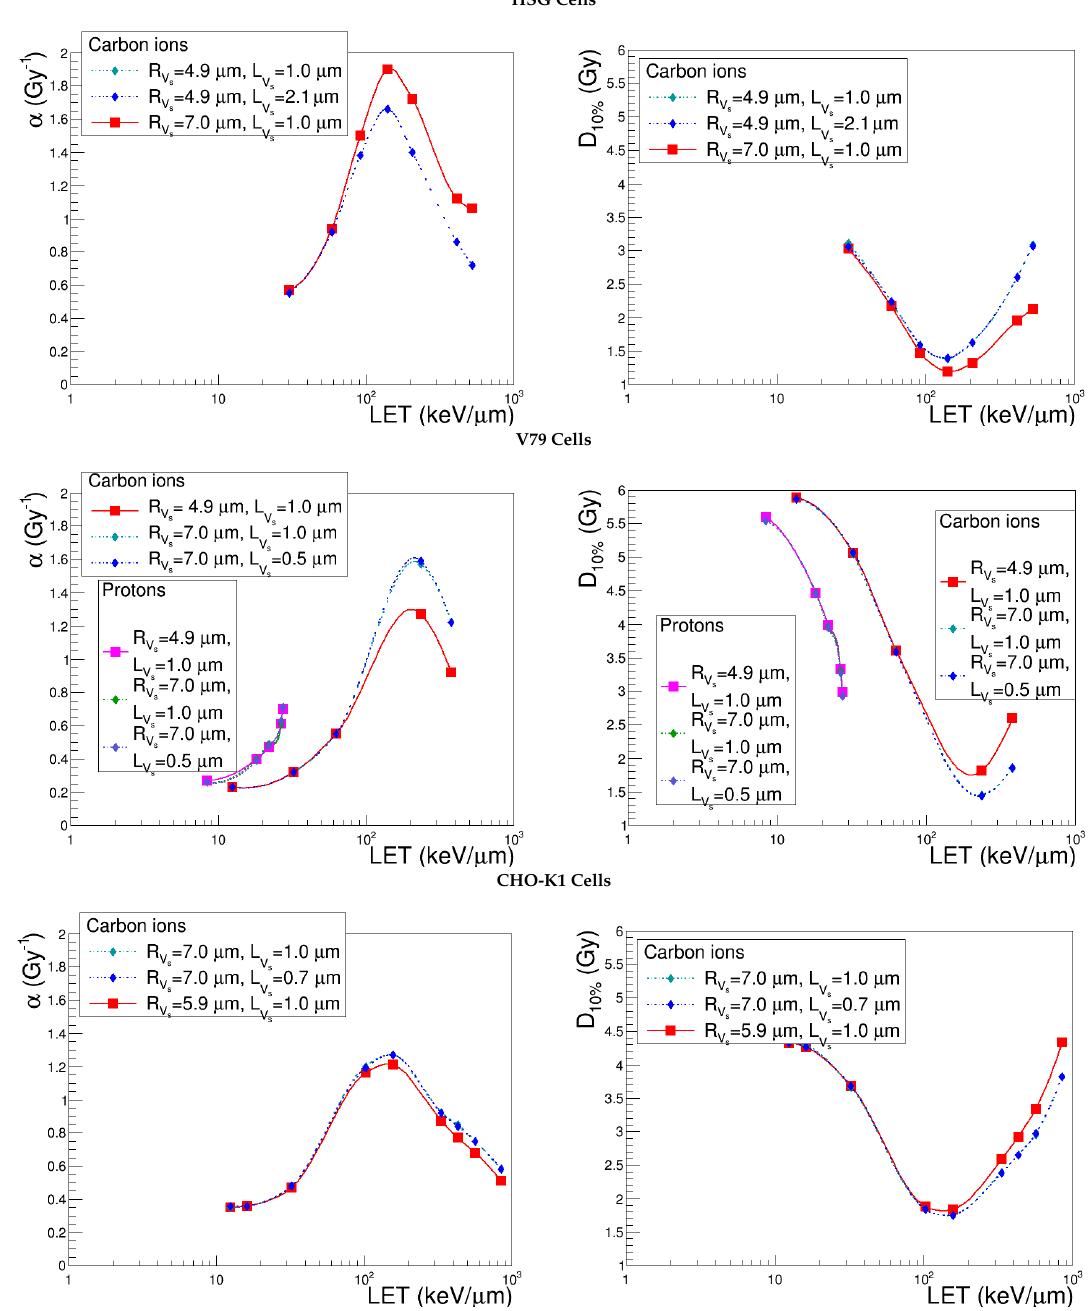
Figure 5. α and D 10% predicted by NanOx for the standard configuration (red curve), a different sensitive volume shape (blue curve) and radius (light blue curve), as detailed in Table 2. The full symbols correspond to the LET values for which the estimates were performed, while the lines are drawn just to guide the eye and do not represent a